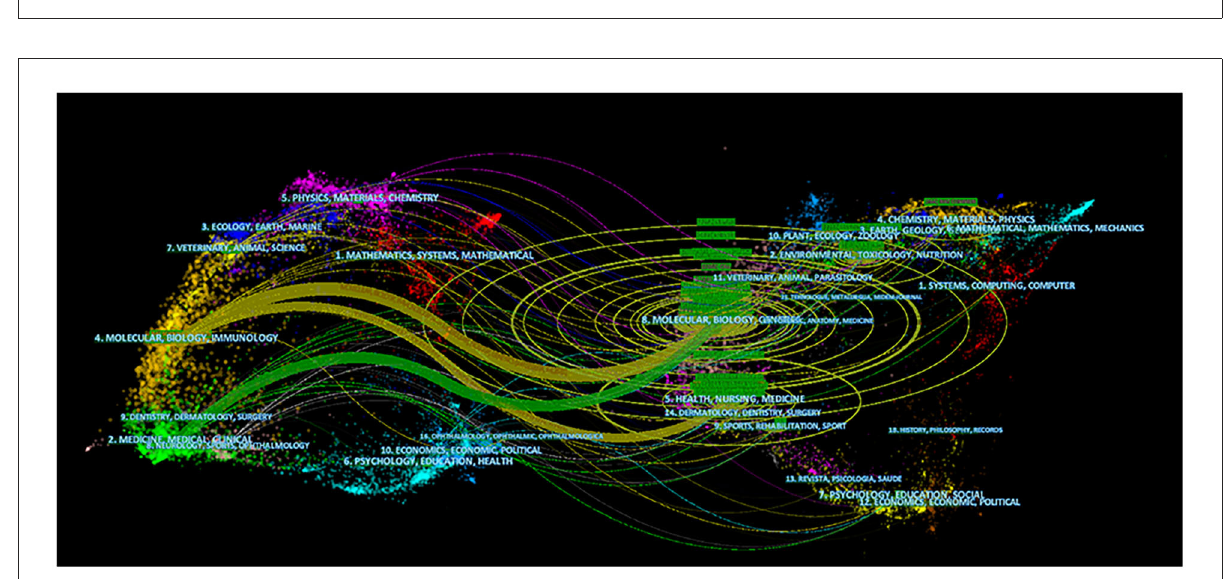
FIGURE7 different clusters. (B) Distribution of keywords according to the average time of appearance; blue represents an early appearance, and yellow represents a late appearance. (C) Top 20 keywords cited the most frequently from 2011 to 2020 and have received continuous attention for a period of time. The red bars represent frequently cited keywords during this time period, and the green bars represent infrequently cited keywords.